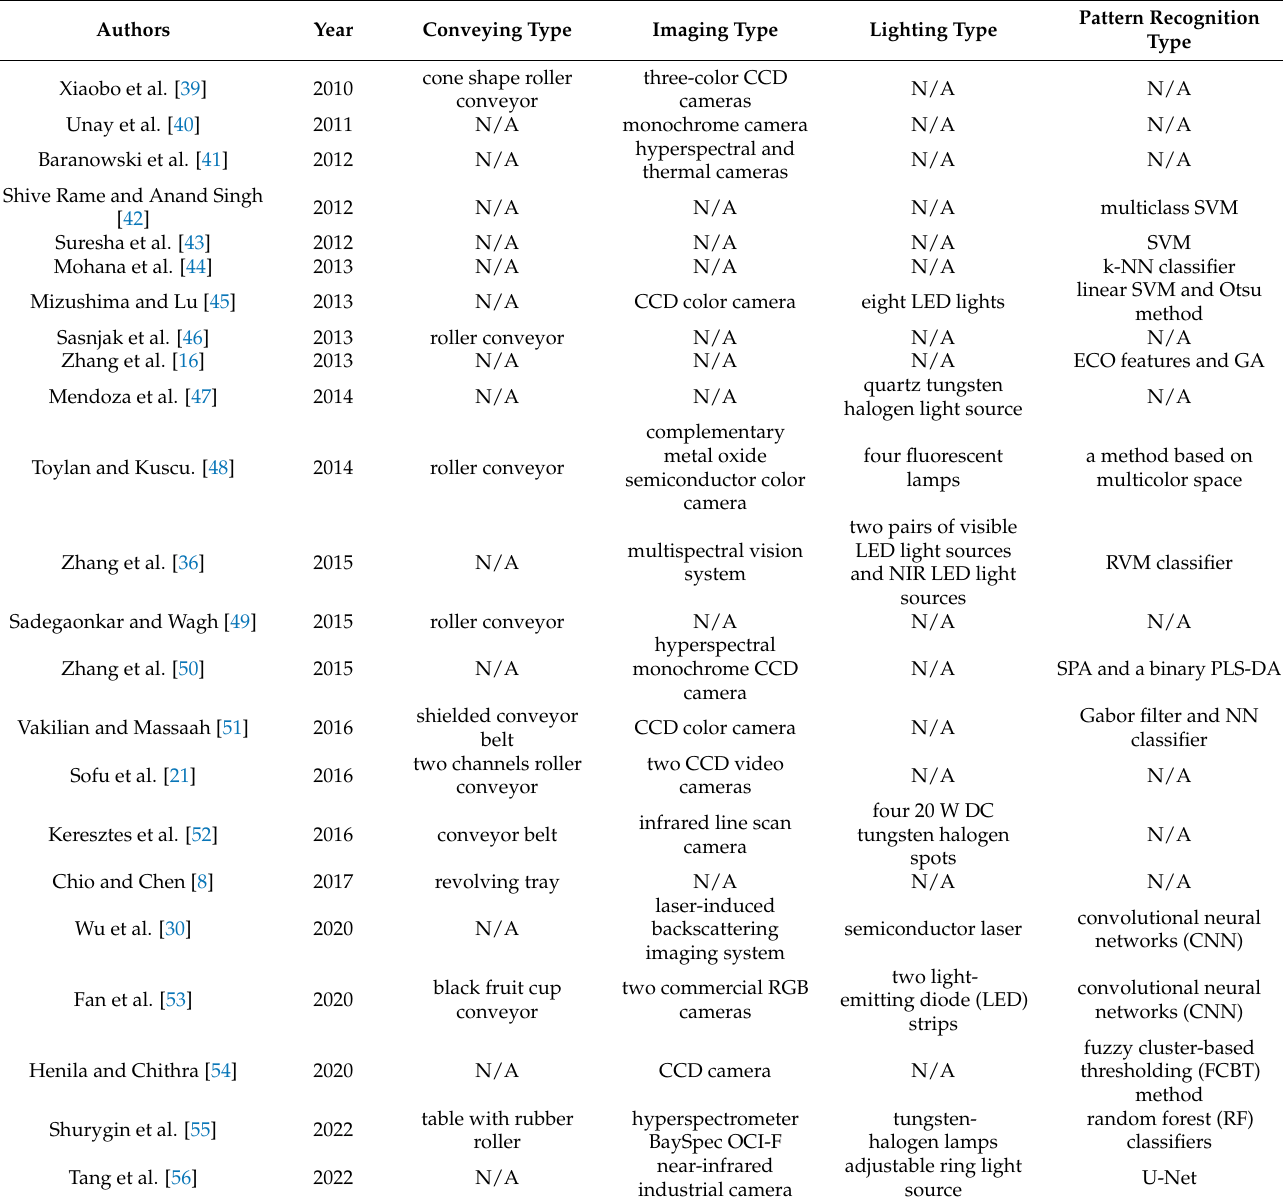
Table 4. The most important mechatronic components applied by different researchers in high-tech apple sorting systems